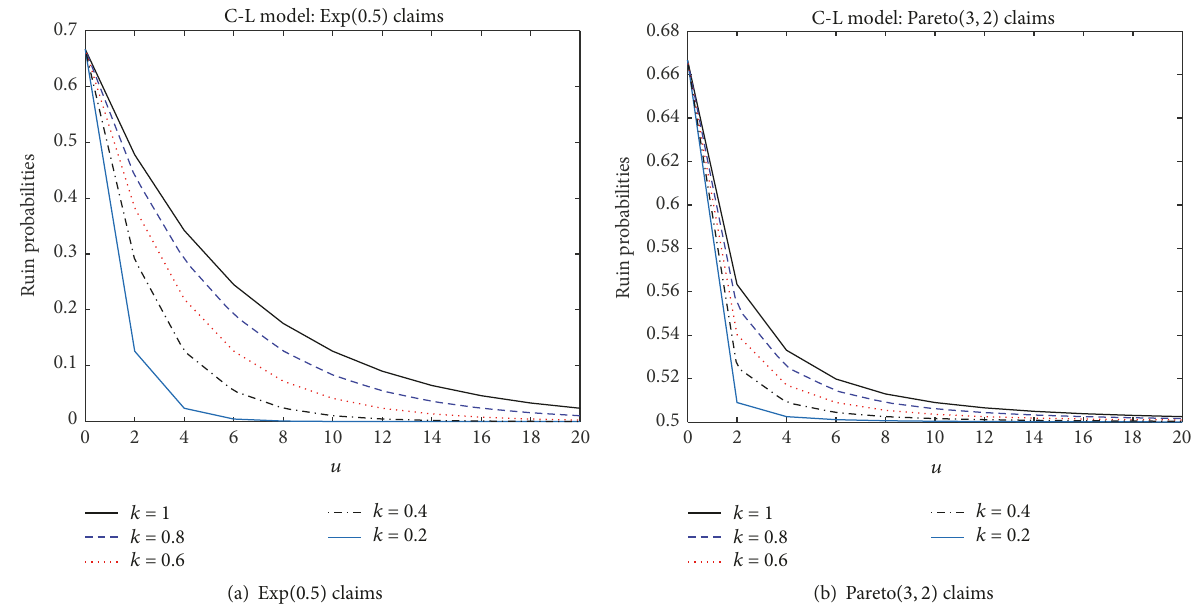
Figure 1: Ultimate ruin probabilities at different proportional retention levels in the Cram´er-Lundberg model: 𝜆 = 2 , 𝑐 = 6 .